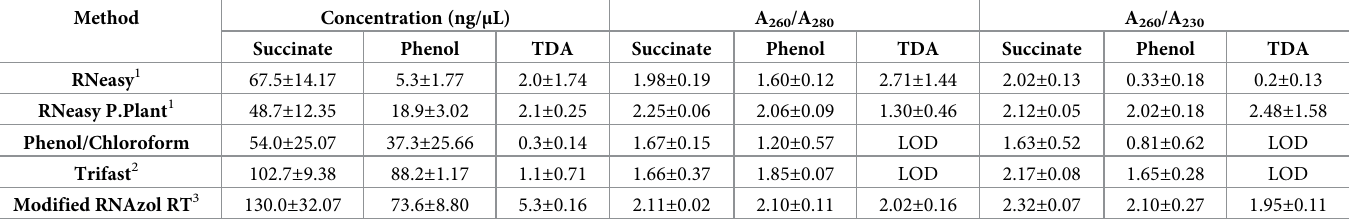
Table 1. Total RNA quantity (ng/ μ L) and purity (A 260 /A 280 and A 260 /A 230 ) for different RNA isolation methods applied on cells from Pseudomonas capeferrum TDA1 growing on different carbon sources (succinate, phenol and 2,4-TDA). Values represent mean ± SD.